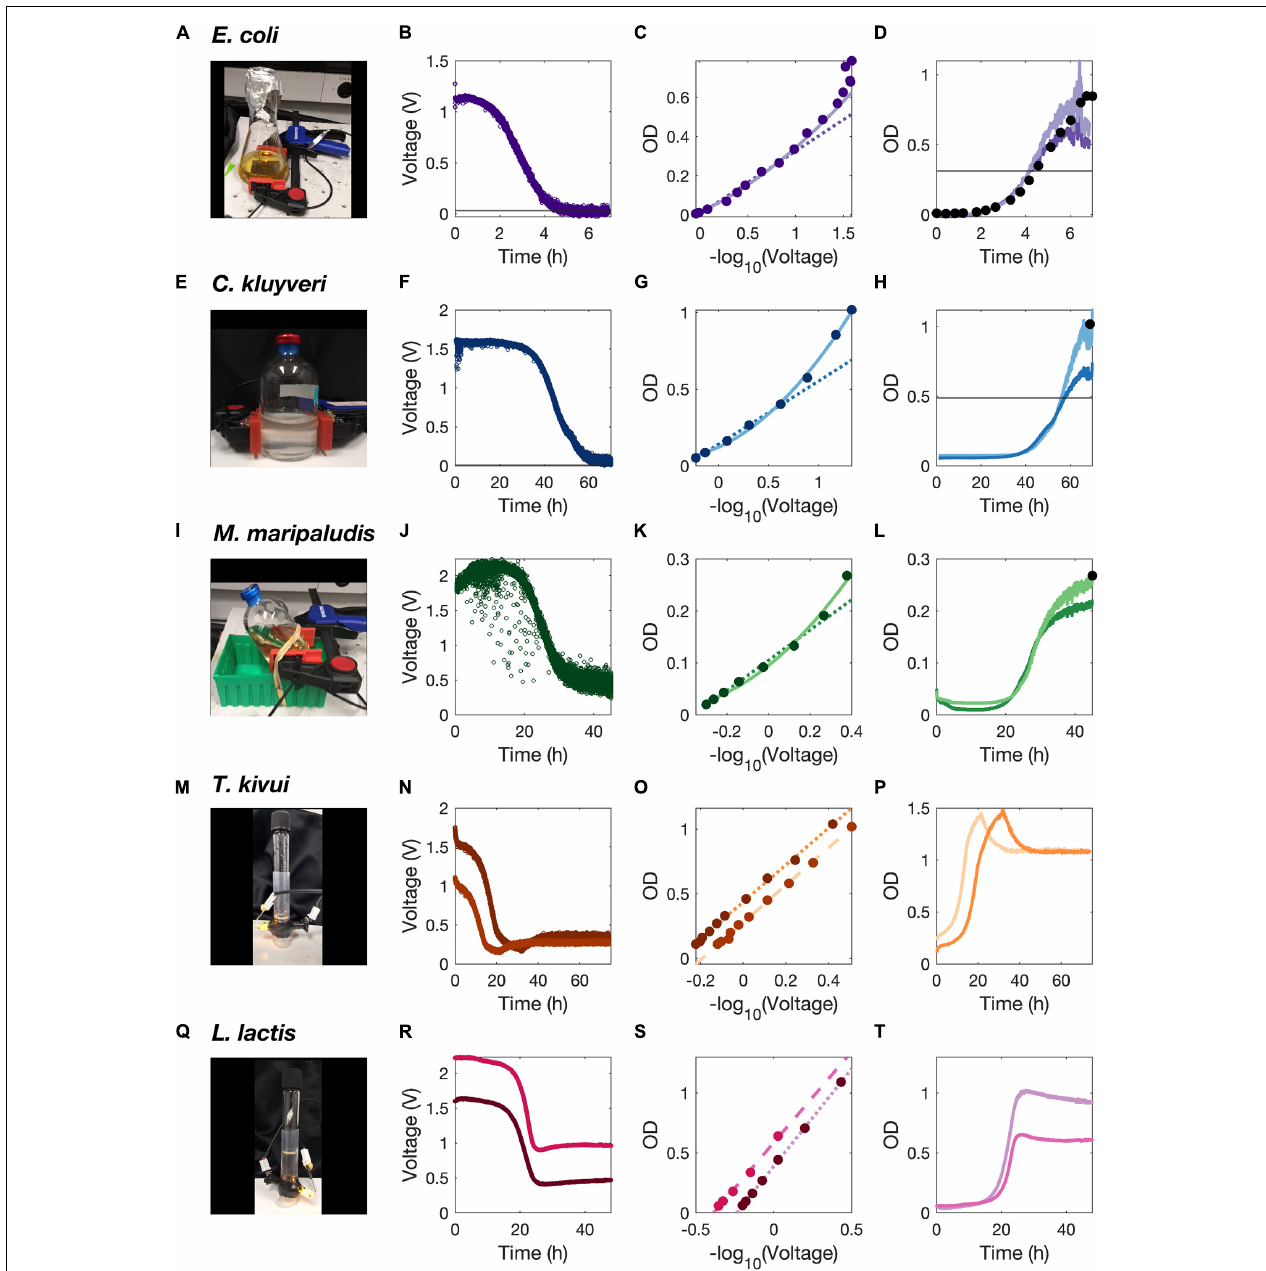
FIGURE 4 | Growth curve measurements of different microbial cultures. Growth of E. coli (A–D) , C. kluyveri (E–H) , and M. maripaludis (I–L) was measured with the ClampOD. Growth of T. kivui (M–P) and L. lactis wild type (darker purple colors) and (cid:49) ldhA mutant (pink) (Q–T) was measured with the TubeOD. Photos of each experimental setup are shown (A,E,I,M,Q) . Raw voltage output from the photosensor was recorded over time (open circles) (B,F,J,N,R) . After recording the growth curves, the cultures were diluted and the OD-meter output was calibrated against a commercial cuvette photometer at a wavelength of 600 nm (filled circles). These points were fitted with first (dotted and dashed lines) and/or second order polynomial regression lines (solid lines) (C,G,K,O,S) . Based on these regressions, growth curves were plotted using calculated (cuvette photometer equivalent) ODs (D,H,L,P,T) . Black filled circles indicate ODs determined simultaneously in a commercial cuvette photometer (D,H,L) . Lighter colors represent growth curves calculated from the second order polynomial fit, darker shades growth curves calculated from the linear polynomial fit (D,H,L) . The growth curve color corresponds to the strain or replicate calibration fit (P,T) .